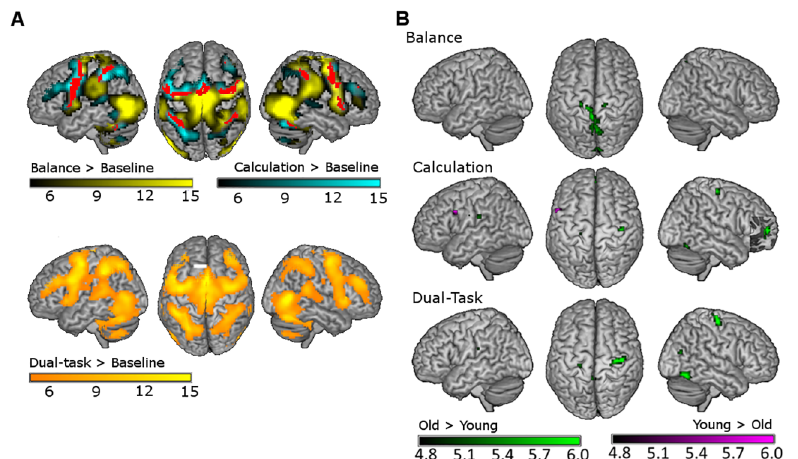
Fig 3. A: Mean brain activationpatterns during balanceand calculation(upper panel), and dual-tasking (lower panel)as comparedwith baseline. Significantlyactivated voxels duringbalance, calculationand dual- tasking, i.e. the main task effects, are shown in yellow, cyan and orangecolors, respectively.Voxels shown in red in the upper panel are those revealedby conjunction analysis(balance AND calculation) and therefore representareas not specific for a single-task. B: Age-related differencesduring balance, calculation, and dual-tasking. Voxels with higher activationin old comparedwith young adults are shown in green, whereas voxels with higheractivationin young comparedwith old adults are shown in purple. Statistical significance was set at p < 0.05, FWE corrected for